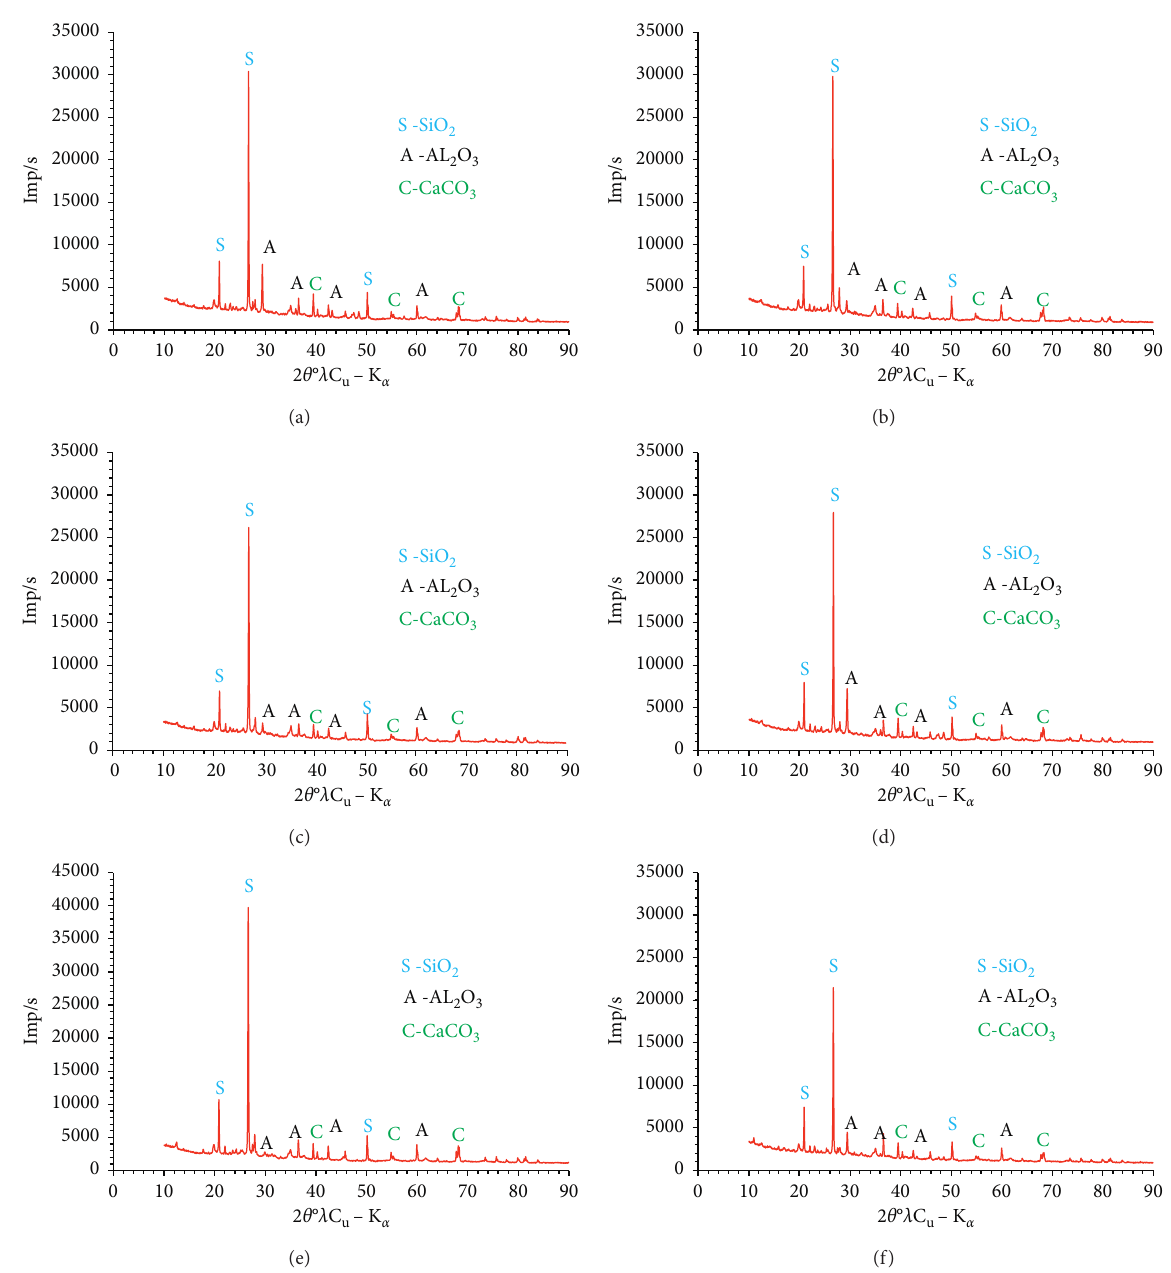
Figure 17: The XRD images of different cement contents and curing ages. (a) Cement content 5% and curing age 7d. (b) Cement content 20% and curing age 7d. (c) Cement content 5% and curing age 28d. (d) Cement content 20% and curing age 28d. (e) Cement content 5% and curing age 90d. (f) Cement content 20% and curing age